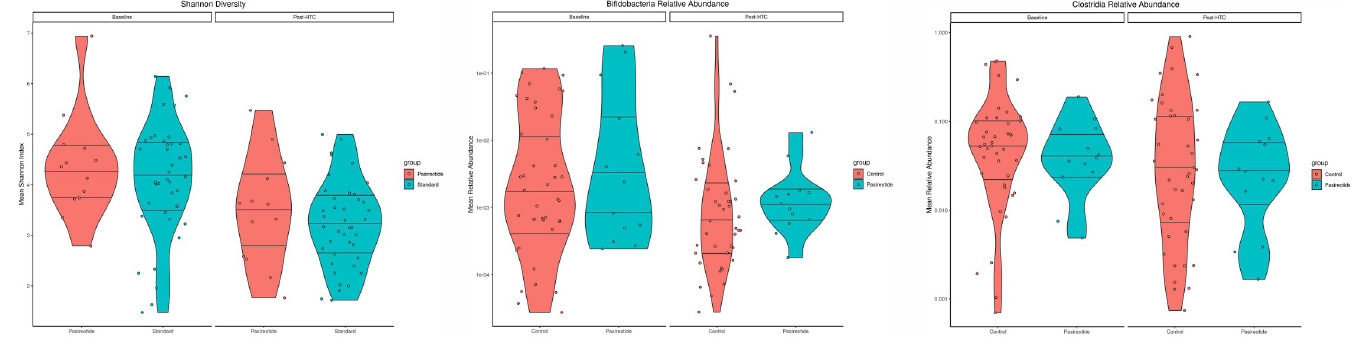
Fig 2. Microbiome results. (A) Mean Shannon Diversity at baseline and post-transplant. (B) Mean relative abundance of bifidobacteria in pasireotide and control groups at baseline and post-HCT. (C) Mean relative abundance of clostridia in pasireotide and control groups at baseline and post-HCT.